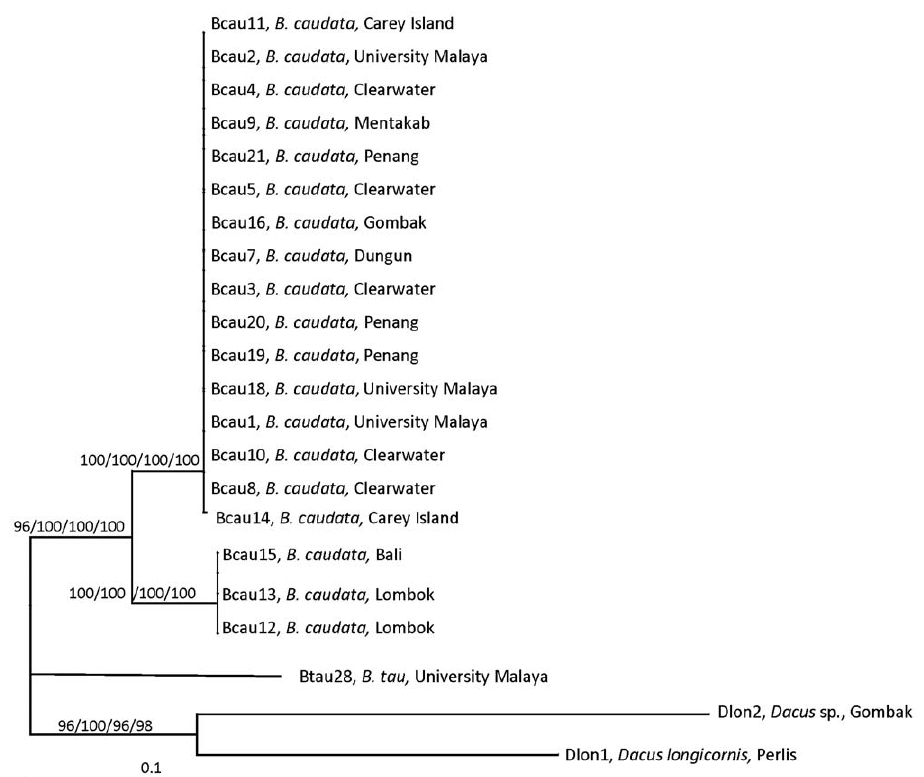
Figure 6. The 50% majority-rule consensus tree resulting from maximum likelihood analysis of combined COI and16S rDNA sequences (substitution rate parameters: TC=0.7202736; TA=0.07817598; TG=0.005510263; CA=0.07817598; CG=0.005510263; AG=0.112354). -Ln likelihood was 2726.135. The bootstrap values (ML/Bayesian Inference/MP/NJ) are shown at the branches. Bar indicates substitutions per site. scutellata (Table 1) – these ‘p’ values are the lowest between two distinct species.